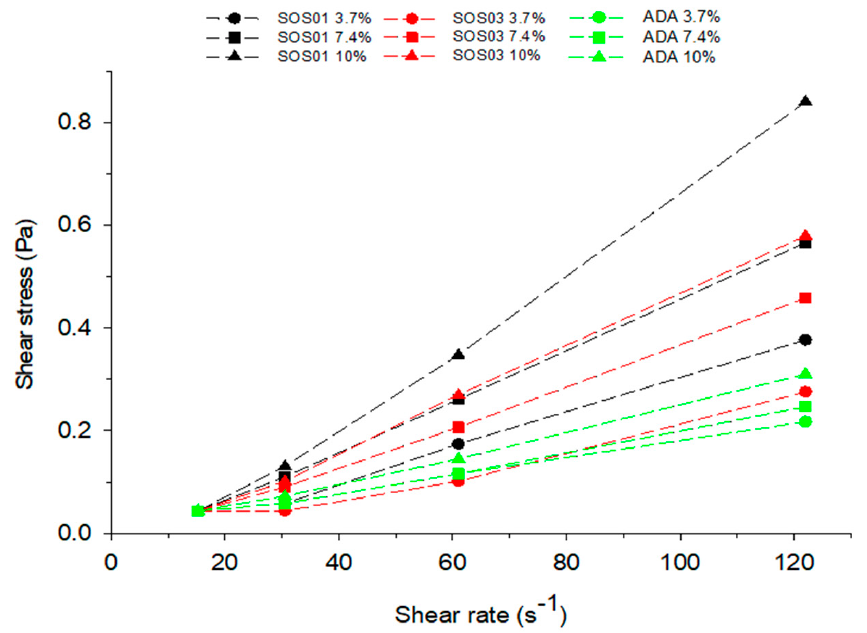
Figure 3. Shear stress vs. shear rate plots for starch grades of sodium octenyl succinate starches (SOS: high viscosity, SOS1 and low viscosity, SOS3) and acetylate di-starch adipate (ADA).